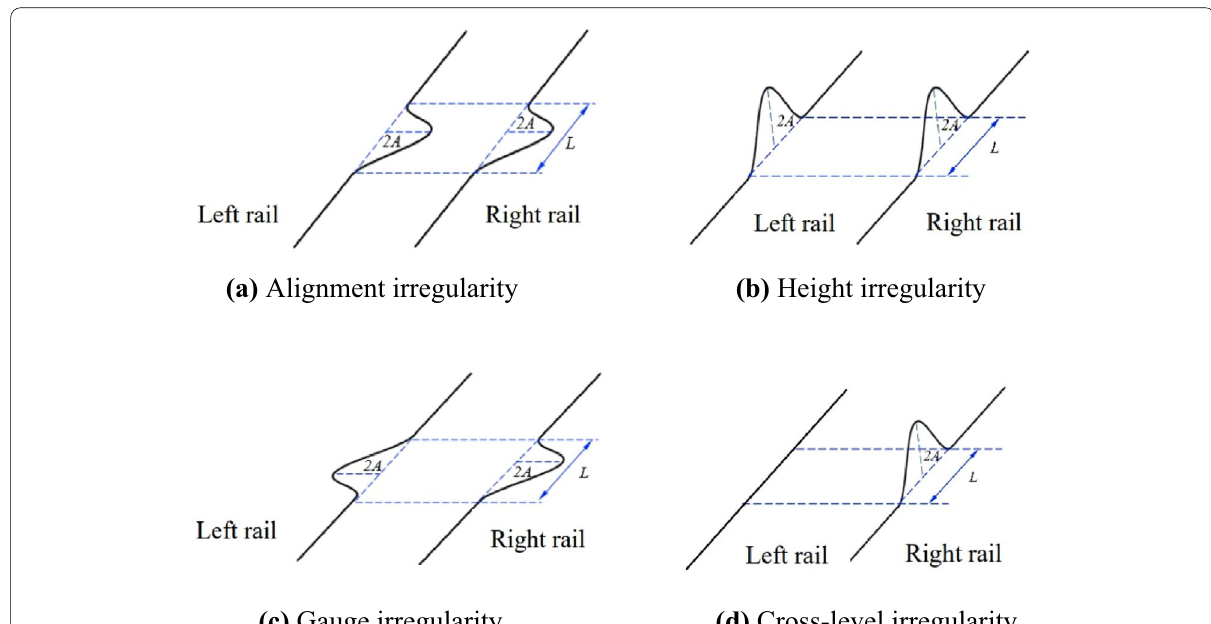
Figure 4 Types of irregularities. L is wavelength, and A is